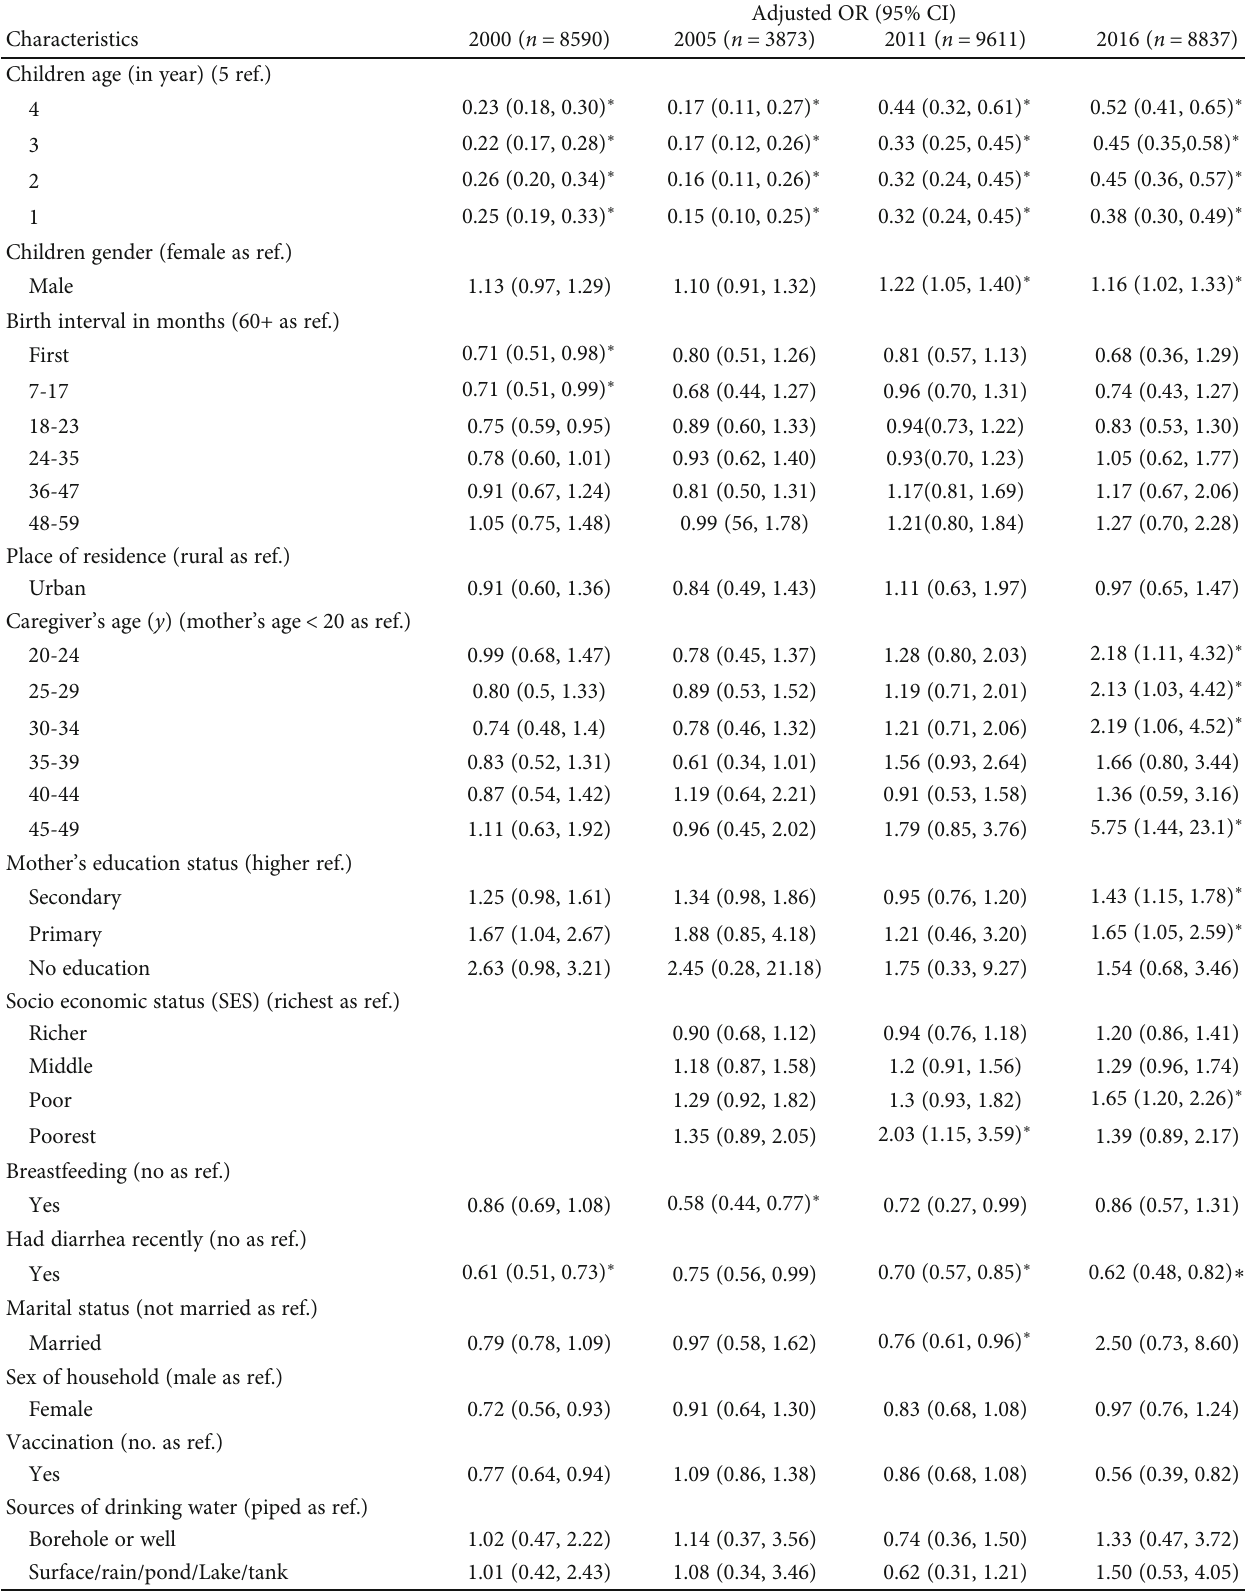
Table 2: Parameter estimates of household, maternal, and child characteristics: EDHS of 2000, 2005, 2011, and